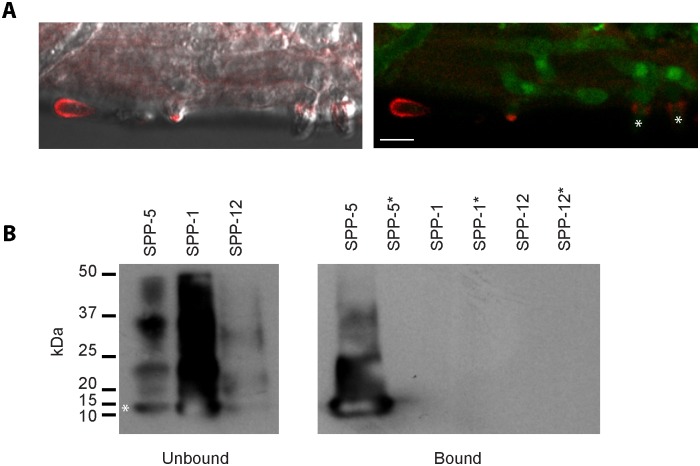
Saposin A-domain protein expression during infection of C. elegans and its in vitro interaction with SPP-5.(A) A strain of D. coniospora engineered to express GFP constitutively and a SapA::dsRed chimeric protein under the control of the sapA promoter, visualized using confocal fluorescence microscope (right panel) combined with differential interference contrast microscopy (left panel), during the infection of C. elegans. In both panels, a bright red fluorescent spore can be seen on the left. In the centre, a mycelium that is starting to exit the worm shows bright red fluorescence at its tip. On the right, 2 adjacent mycelia that have emerged can be seen. At the point where they leave the epidermis, a ring of SapA::dsRed can be seen, marked by asterisks in the right-hand panel. A general, less concentrated, signal can also be seen in the infected tissue. Worms had been infected for 60 h before images were taken. Scale bar = 5 μm. (B) Physical interaction between SPP-5 and SapA::dsRed. Recombinant His-tagged SPP-1, SPP-5 or SPP-12 was mixed with a protein extract from fungi expressing SapA::dsRed. The mix was analysed by Western blot probed with an anti-His-tag antibody before (left hand panel) or after (right hand panel) immunoprecipitation with anti-dsRed antibody-coated beads. In the sample before immunoprecipitation, in addition to the band at the expected size (11.9 kDa) marked by an asterisk, higher molecule weight species were detected, corresponding to the previously described oligomerization [86]. SPP-5 was co-immunoprecipitated with SapA::dsRed, principally in its monomeric form, but not if incubated with blocked beads (lanes marked with an asterisk; a control for non-specific binding). Neither SPP-1 nor SPP-12 gave any indication of co-immunoprecipitating with SapA::dsRed, even if SPP-1 was more abundant in the sample before immunoprecipitation.